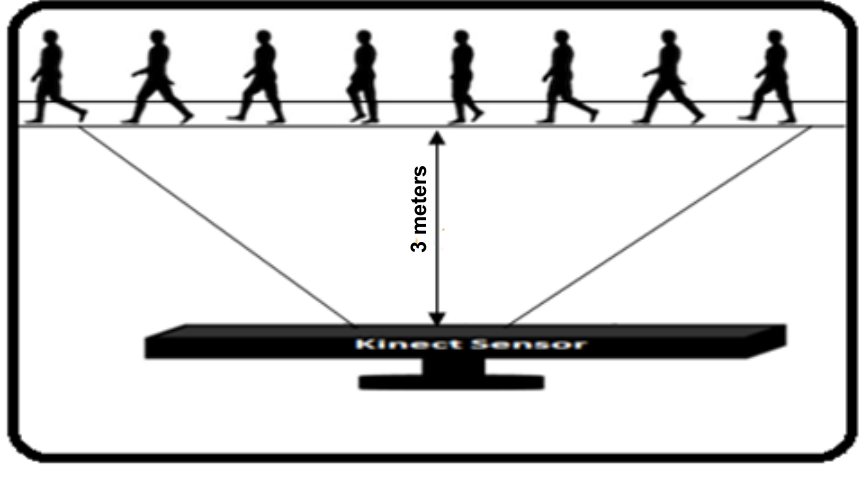
Figure 5. Walking direction of